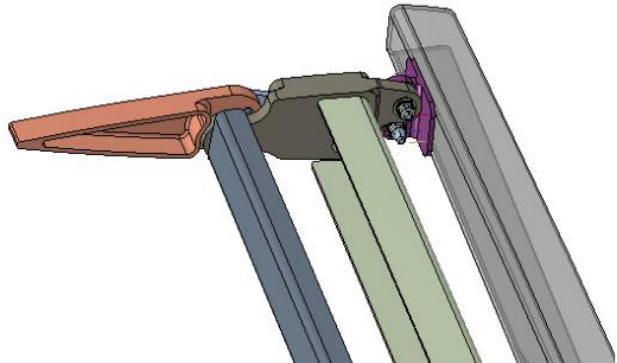
Figure 6. Finger-like mechanism of the upper morphing tab of the winglet, [34]. Figure taken with permission from authors.